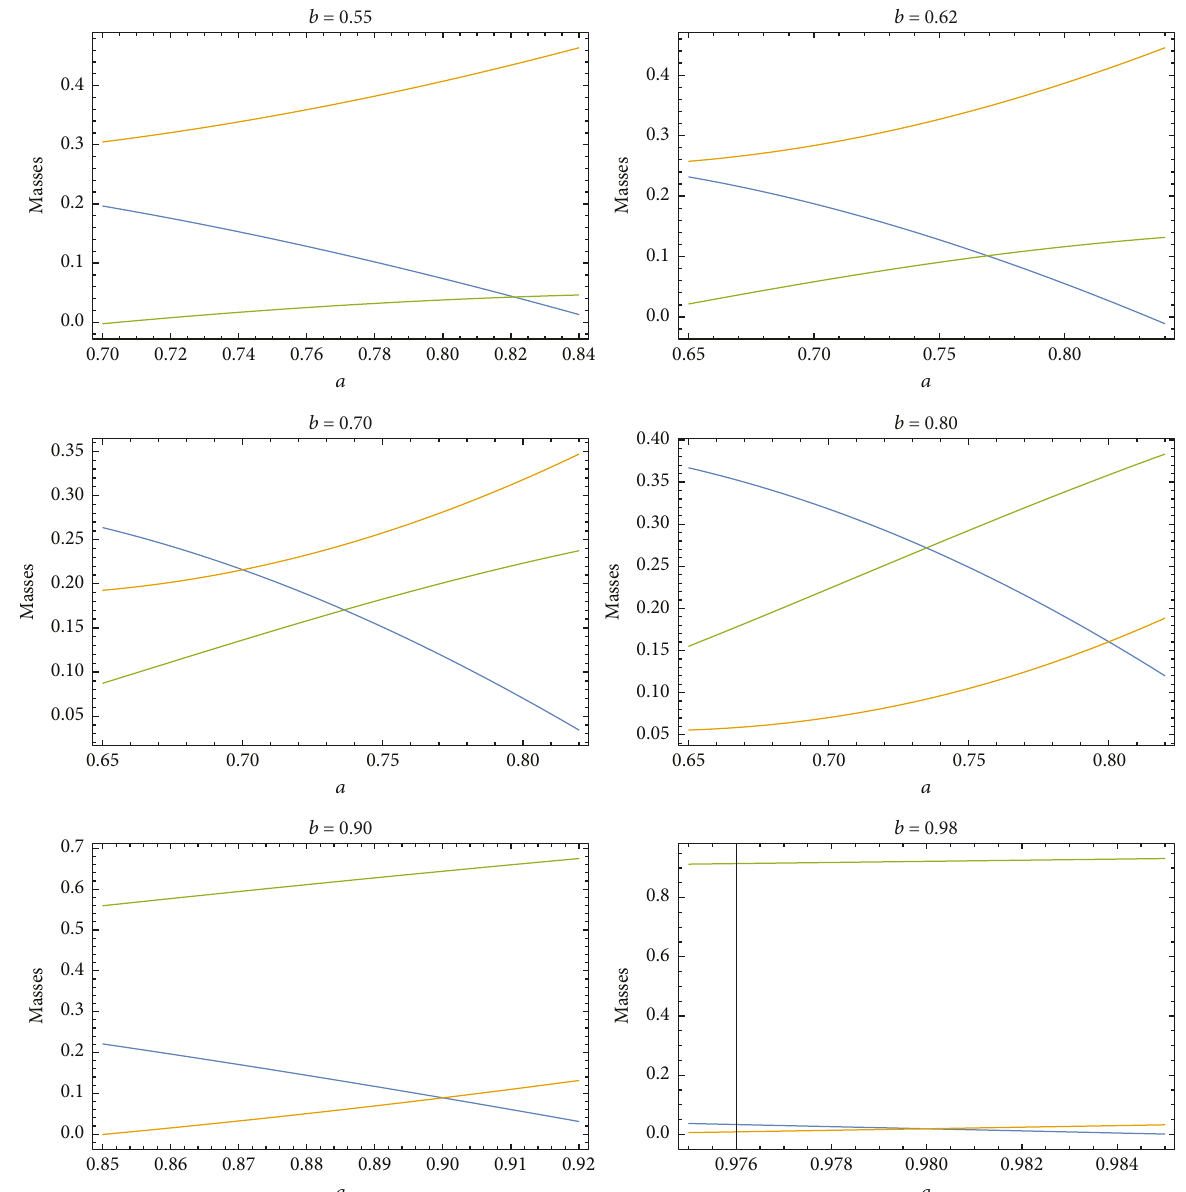
Figure 5: Variations of primary masses m